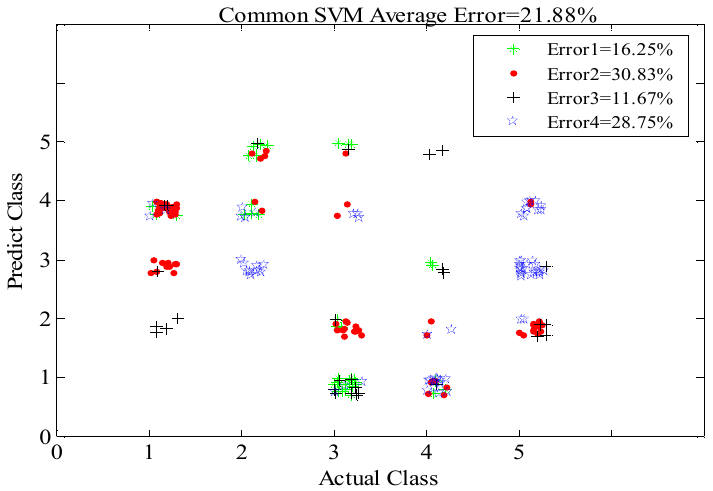
Figure 12. Four-fold cross-validation error distribution of the reference method at changing positions. Sensors 2016 , 16 , 885